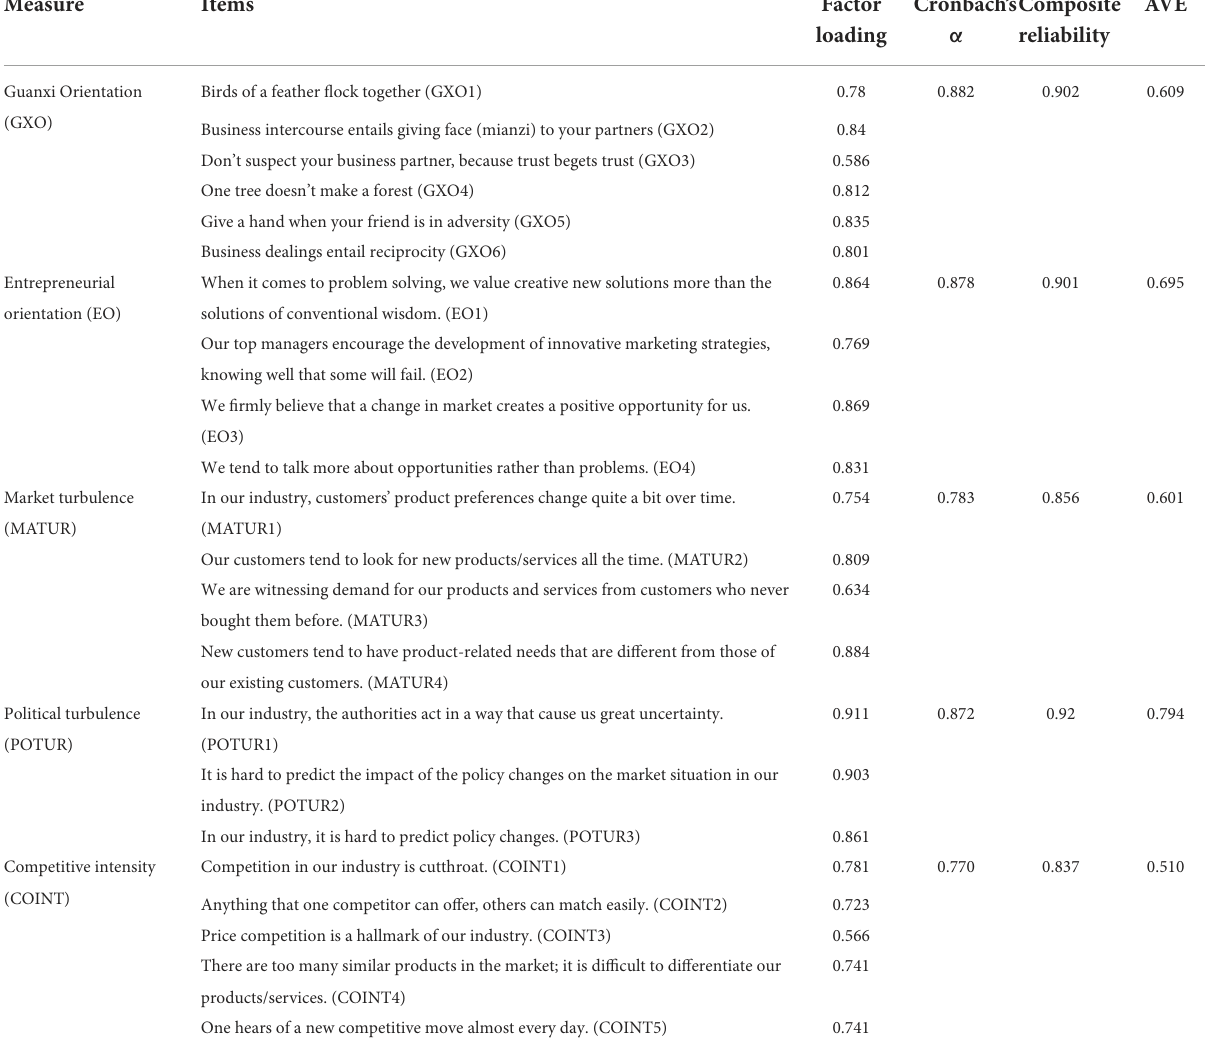
TABLE 2 Assessment of reflective measures. Measure Items Factor